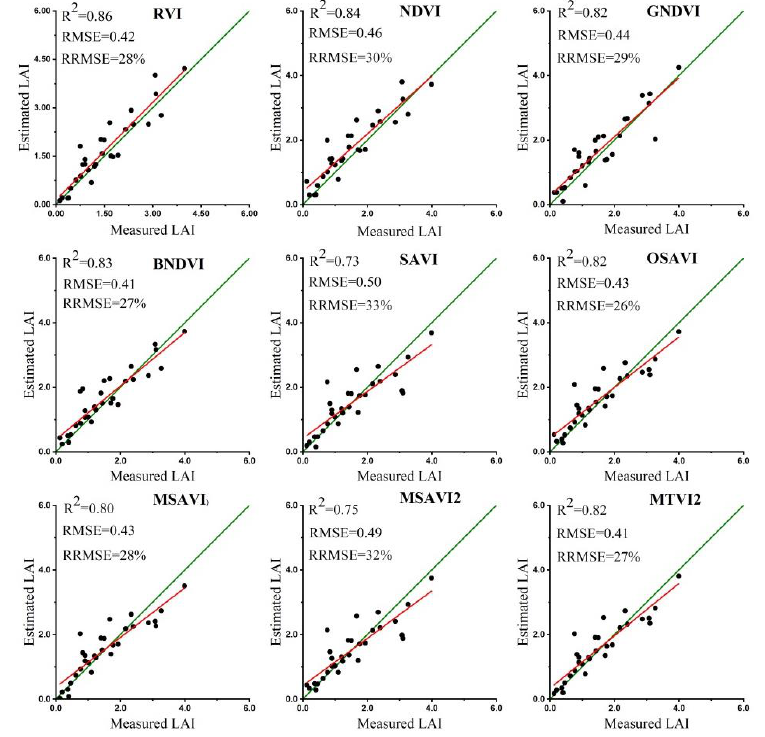
Figure 5. Estimated vs. measured LAI at the flowering stage. The green line shows the 1:1 correlation of the estimated and measured variables, whereas the red lines represent the linear regression models.